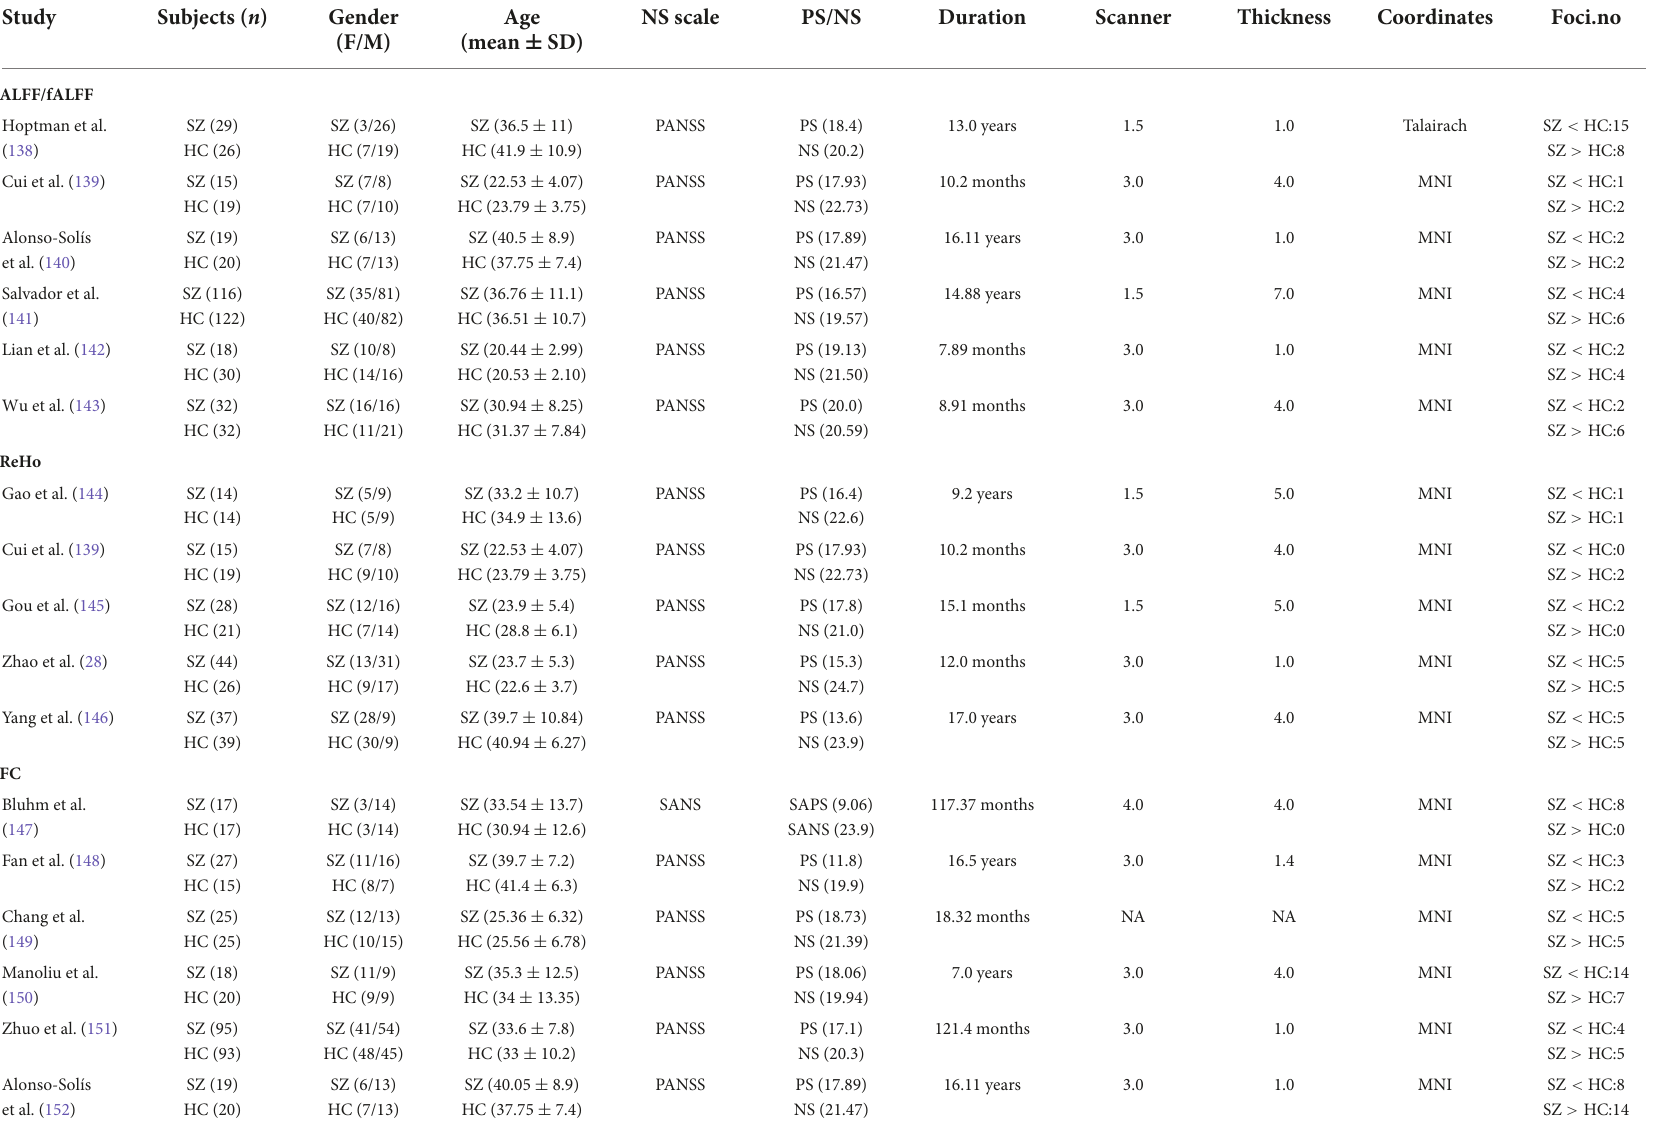
TABLE 2 Demographic and clinical information for the functional MRI studies included in the